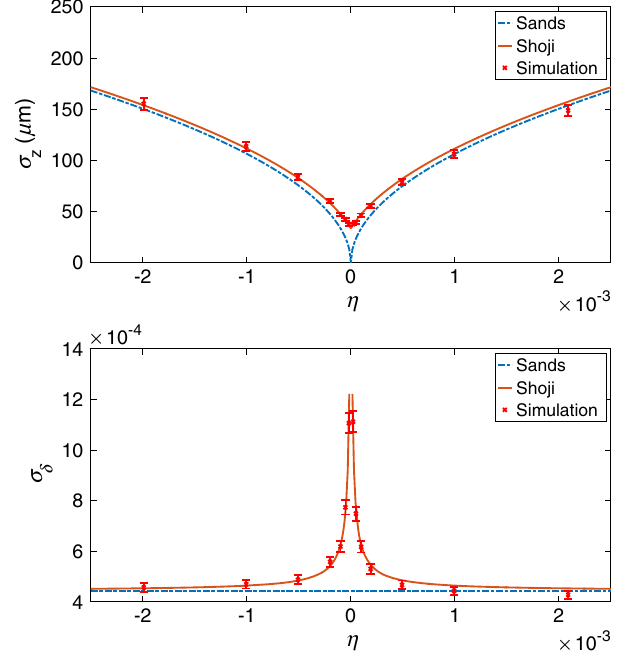
FIG. 4. Bunch length saturation and energy widening as the global phase slippage factor η approaches zero as a result of longitudinal quantum radiation excitation. The simulation was conducted using the parameters of the MLS low-alpha user lattice at a beam energy of 630 MeV and with the application of an extremely high rf voltage of 50 MV. A single particle was tracked for 2 × 10 7 turns, corresponding to approximately 291 longi- tudinal damping times, using the simulation code ELEGANT [31] to obtain the statistical bunch length and energy spread in each